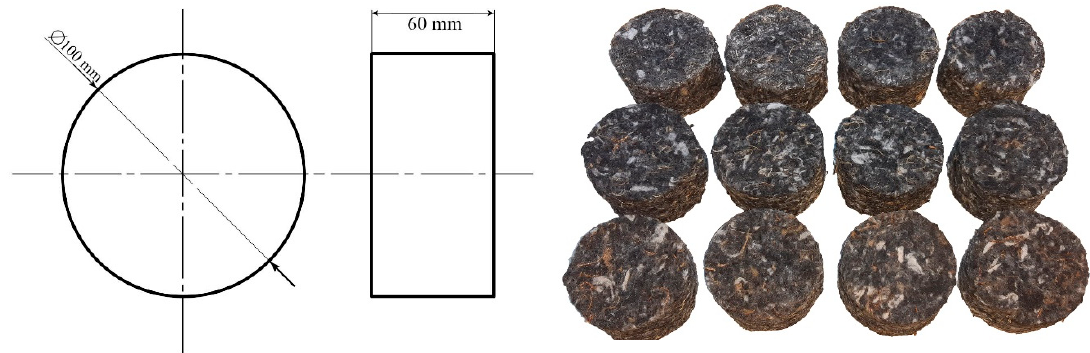
Figure 2. Dimensions of samples for sound absorption coefficient measurement. Measurement of sound coefficient was performed according to ISO 10534-2 [29]. The test method covers the use of an impedance tube, two microphones and a digital fre- quency analysis system. This two-microphone method of measuring sound absorption is based on decomposition of a broadband random signal into a signal from a source and a reflected signal. The complex acoustic transfer function is calculated from obtained values of acoustic pressure. From these values is possible to determine sound absorption coeffi- cient and reflectance coefficient for all frequencies [30]. The measuring device consists of an impedance (Kundt´s) tube Brüel & Kjær type 4206, a PULSE 14 system, on LAN-XI module Brüel & Kjær type 3050 with two active inputs and CPB (Constant Percentage Band), a sound signals generator, two identical mi- crophones and a computer to display and save measured data (Figure 3) (Brüel & Kjær an HBK company, Nærum, Denmark). Measurement of sound absorption coefficient was performed in frequency range of 20 Hz to 2 kHz, using Kundt´s tube with a diameter of 100 mm. Another investigated parameter was the Noise Reduction Coefficient (NRC). It is a single-number rating which represents the average of sound absorption coefficients of a material at specific mid-range frequencies (tested at 250, 500, 1000 and 2000 Hz octaves) rounded to nearest 0.05. This value is influenced by thickness and density of material [31].